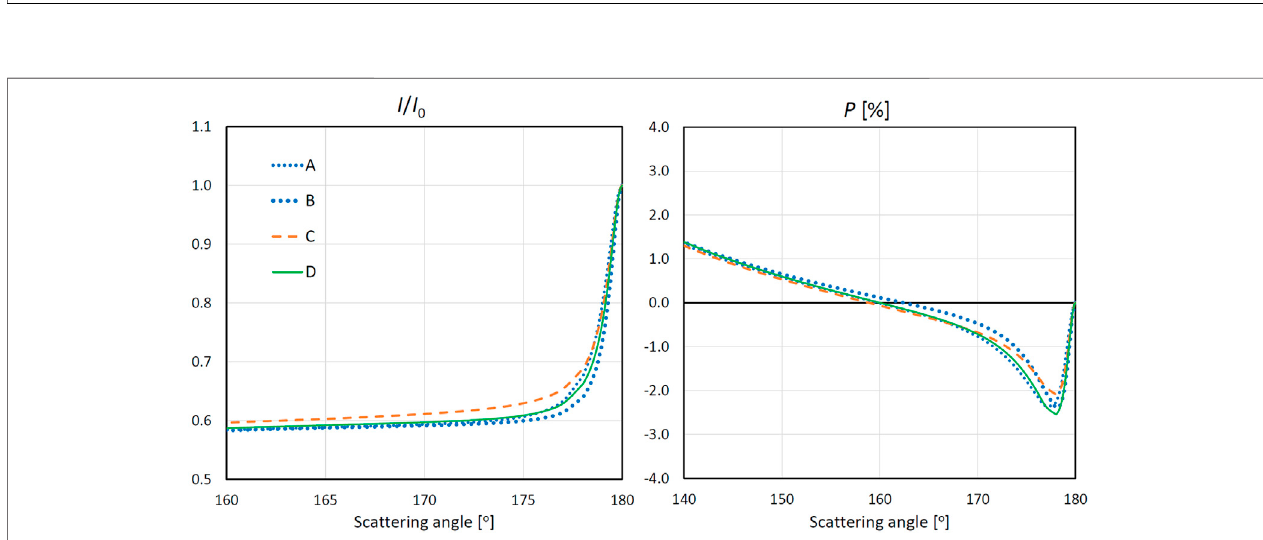
FIGURE 3 | The normalized intensity I / I 0 and the degree of linear polarization P of light re fl ected by a discrete random medium in dependence on the scattering angle, which were obtained with models A − D and ξ = 10%. The values of x and m are speci fi ed in the text.